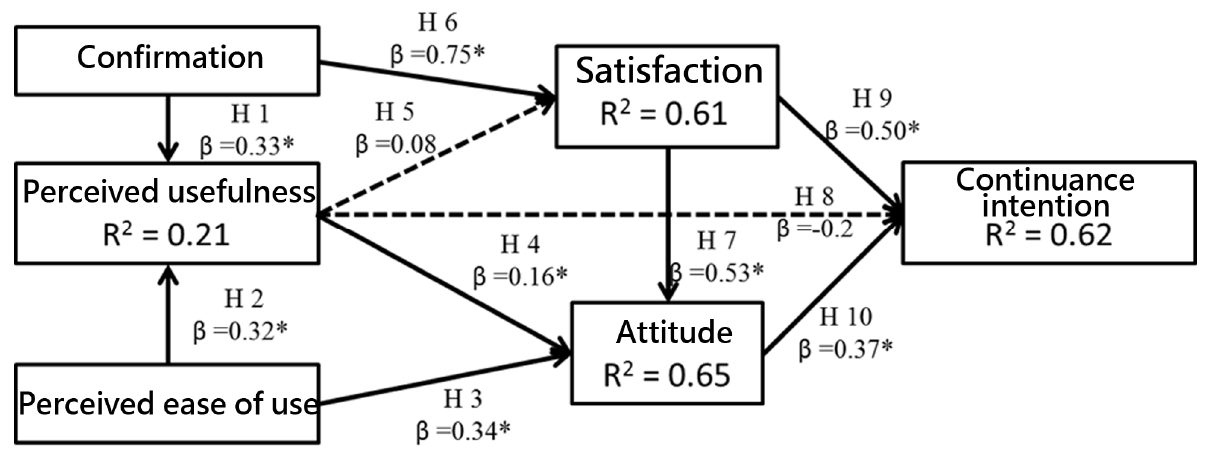
Figure 2. Path analysis of variables in research framework (manual search); Note: * p < 0.001. Table 3. Confirmatory factor analysis results for preload-based Table 3. Confirmatory factor analysis results for preload-based comparison. Table 3. Confirmatory factor analysis results for preload-based comparison.